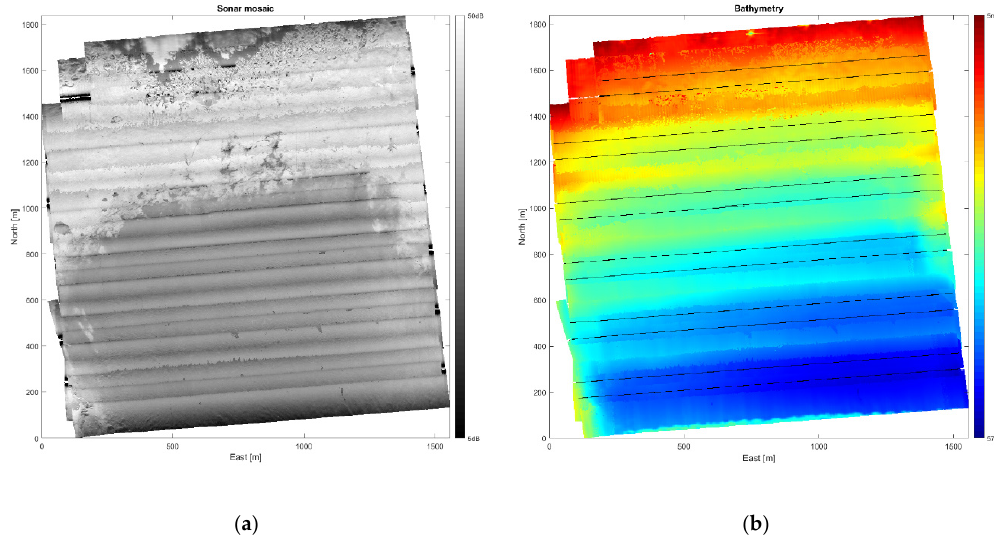
Figure 5. ( a ) SAS image mosaic from the survey in the bay off Elba island; ( b ) Measured bathymetry and AUV tracks.